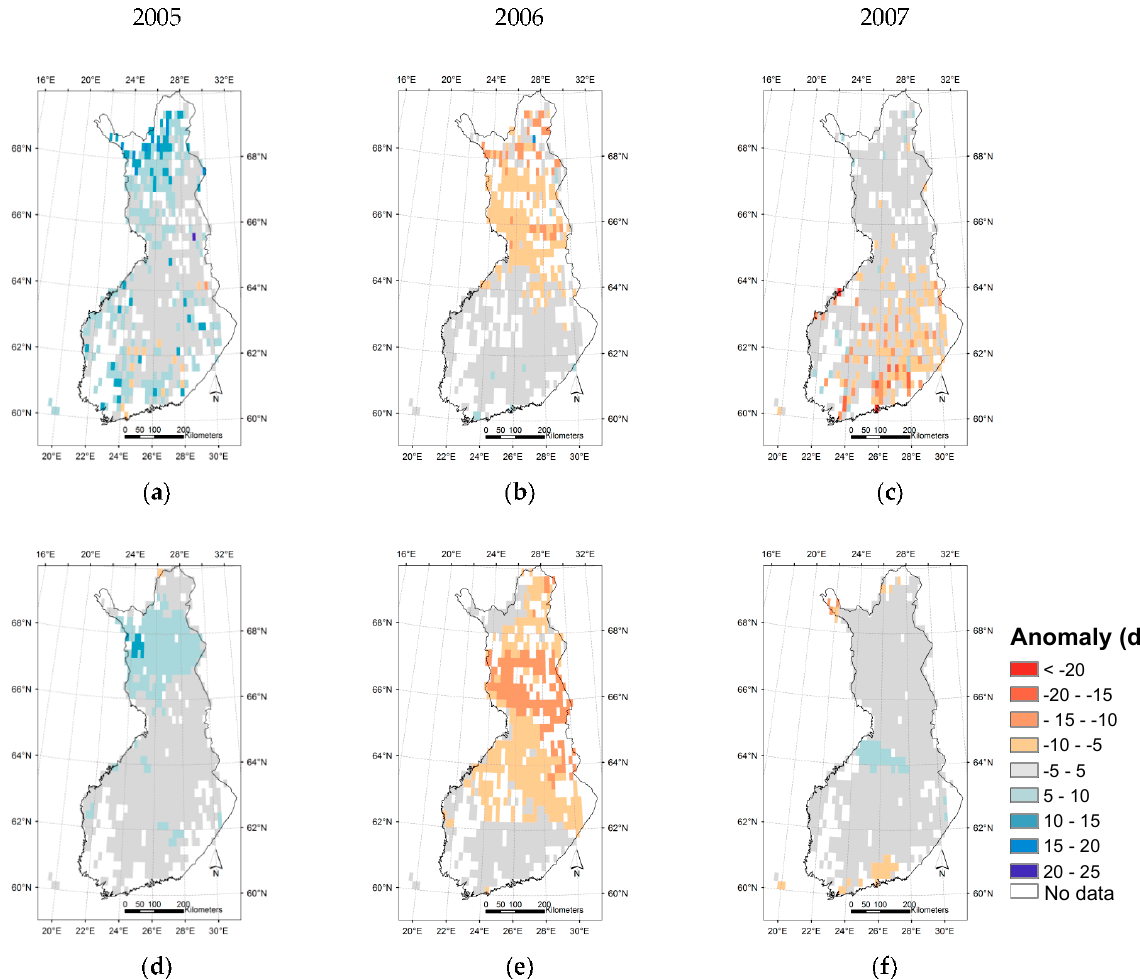
Figure 12. ( a – f ) Spatial distribution of yearly anomalies, the deviations (in days) from grid cell mean 2003–2010, of the start of season of deciduous broad-leaf forest. Upper panel: remote sensing estimate (DBF_SOS sat ). Lower panel: model-derived estimate (DBF_SOS mod ).